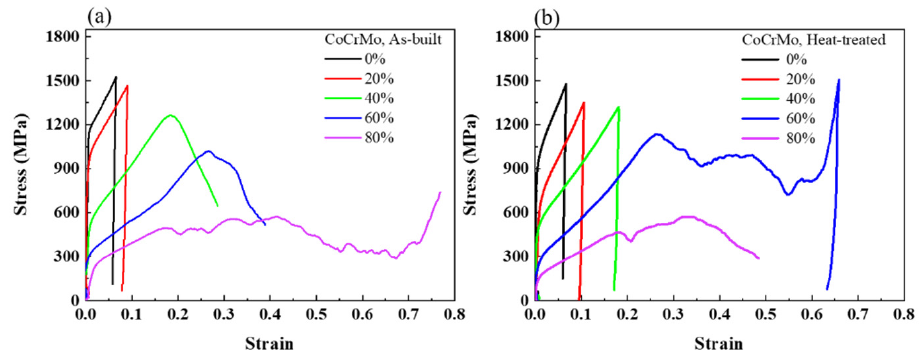
Figure 6. Compressive stress-strain curves of the ( a ) as-built and ( b ) heat-treated CoCrMo alloys with different, designed volume porosities. with different, designed volume